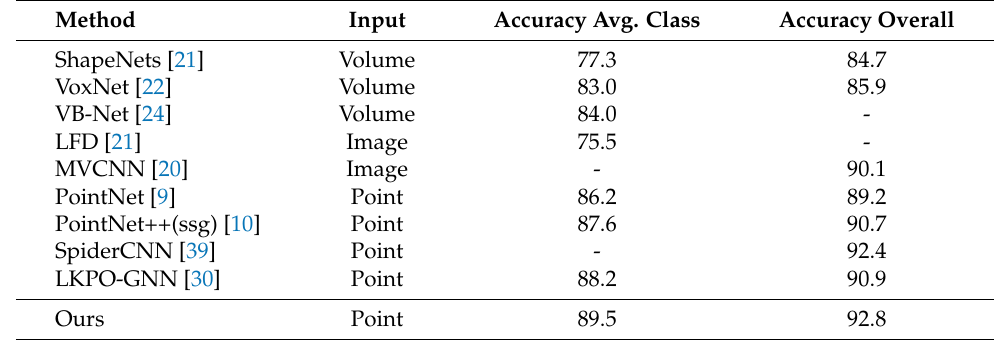
Table 1. Comparison of Classifification results on